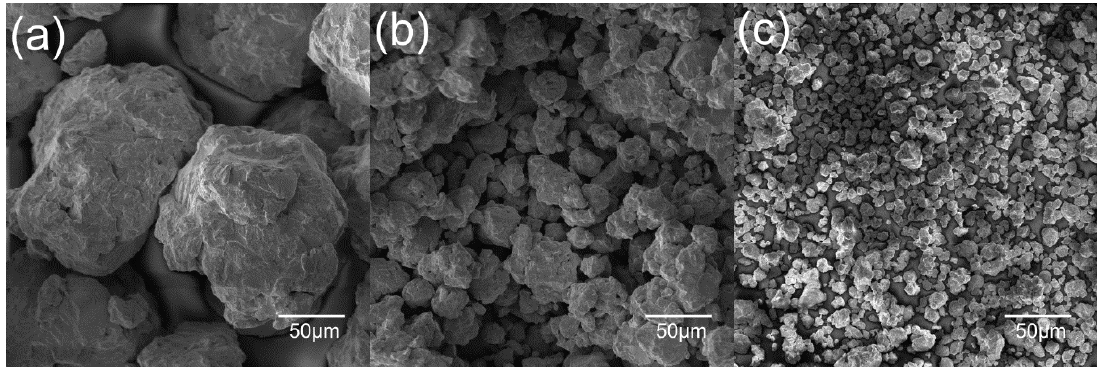
Figure 2. Scanning electron microscope (SEM) microphotographs of Ti23Mo ( a ), Ti27Mo ( b ), Ti35Mo ( c ) powders after 48 h of MA.